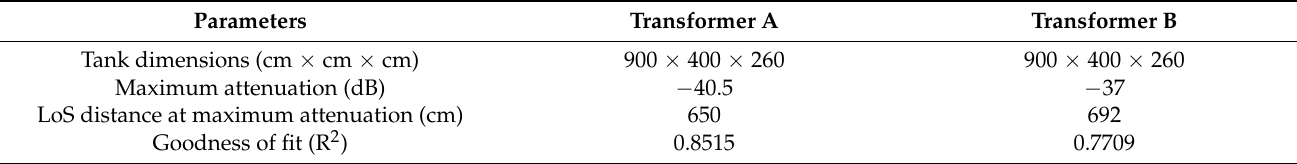
Figure 5. ( a ) Signal attenuation in transformer B with the corresponding fit curve; ( b ) comparison of fit curves of transformers A and B. Table 1. Comparison of quantitative parameters between transformers A and